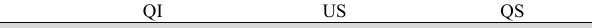
The results of discriminant reliability and